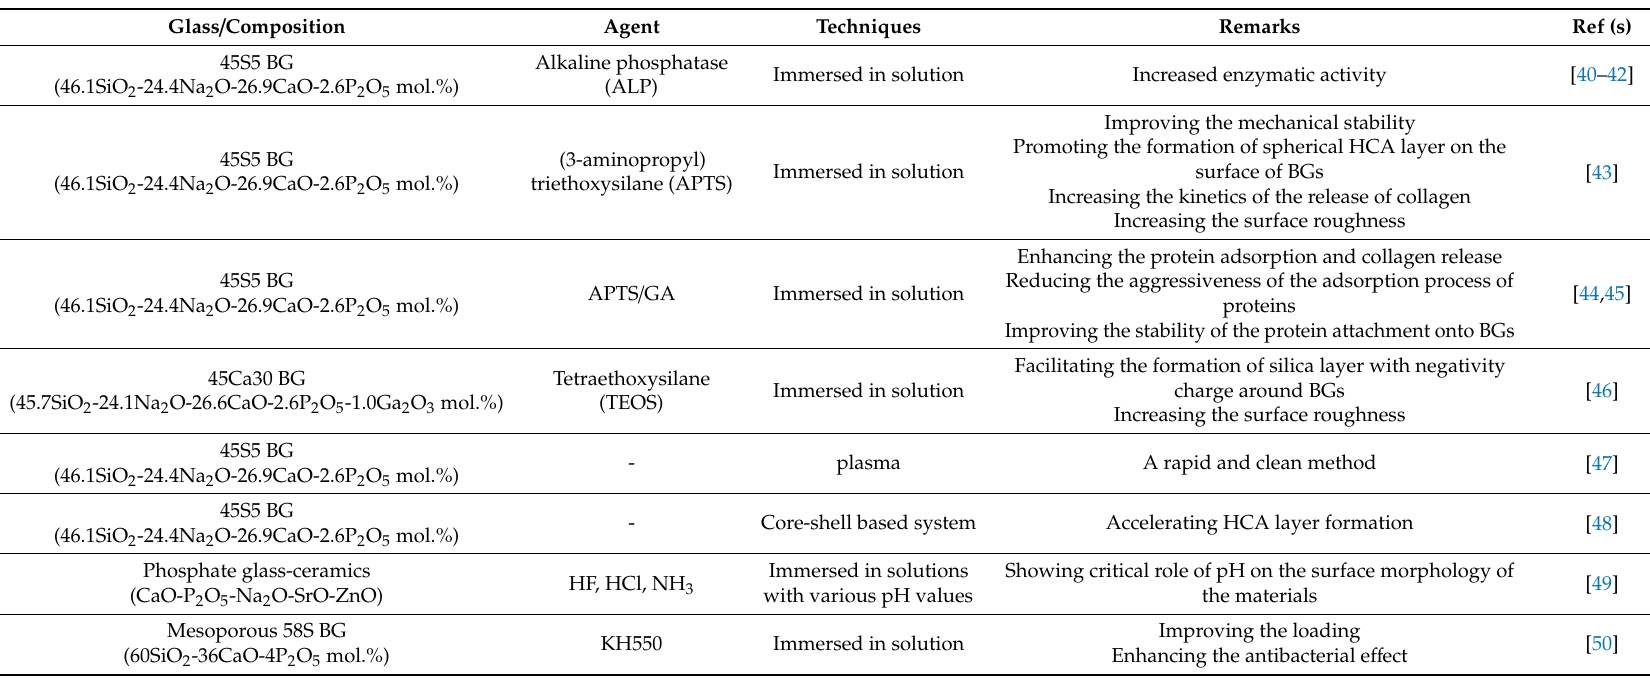
Table 1. A summary of previously performed studies with the aim of surface modification and functionalization of